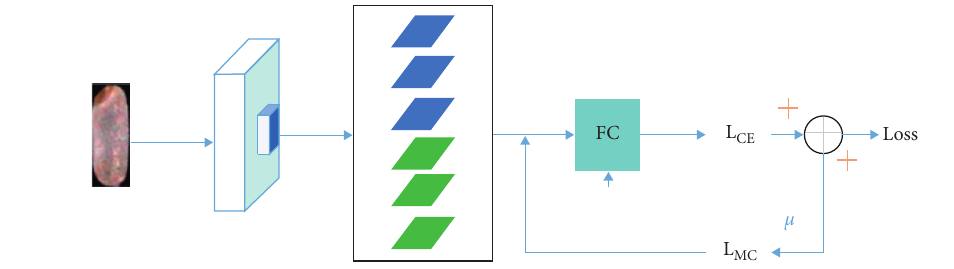
Figure 13: Model frame diagram.